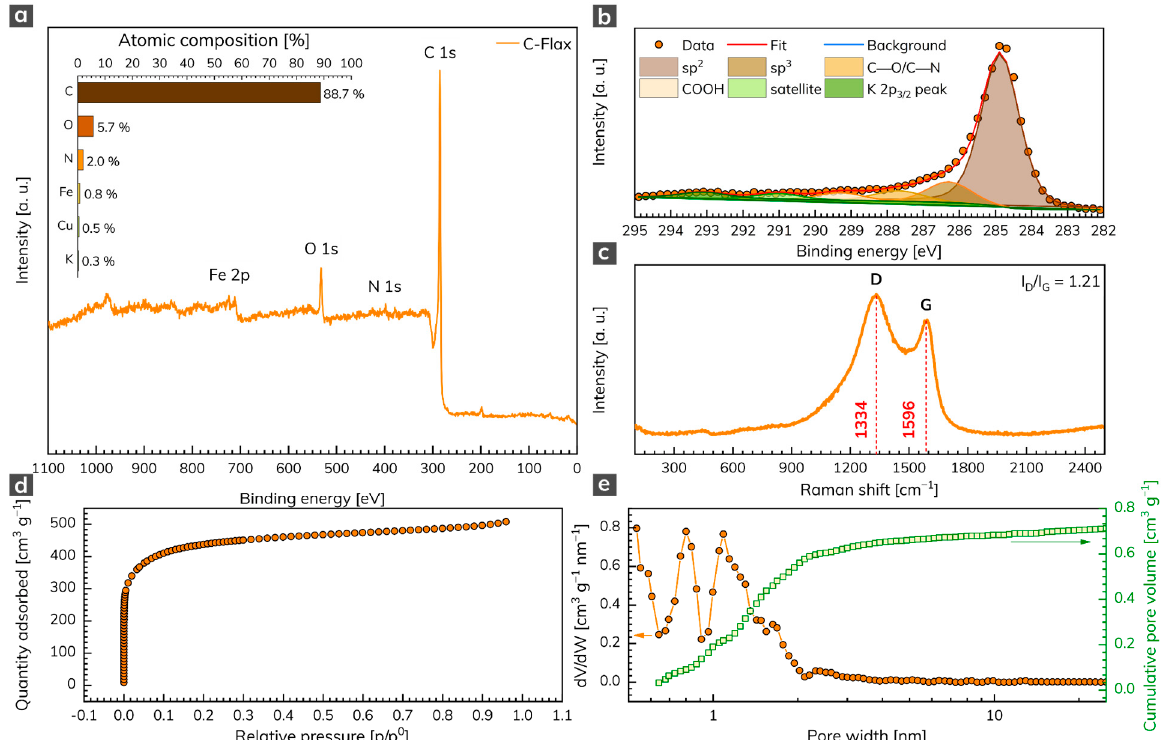
Figure 1. ( a ) XPS survey spectrum of C 1s, N 1s, O 1s, and Fe 2p with related atomic % weight contributions (inset). ( b ) Deconvoluted C 1s peak. ( c ) Raman spectrum of C-Flax sample. ( d ) Adsorption/desorption isotherm of C-Flax sample and its ( e ) related pore size distribution and cumulative pore volume.